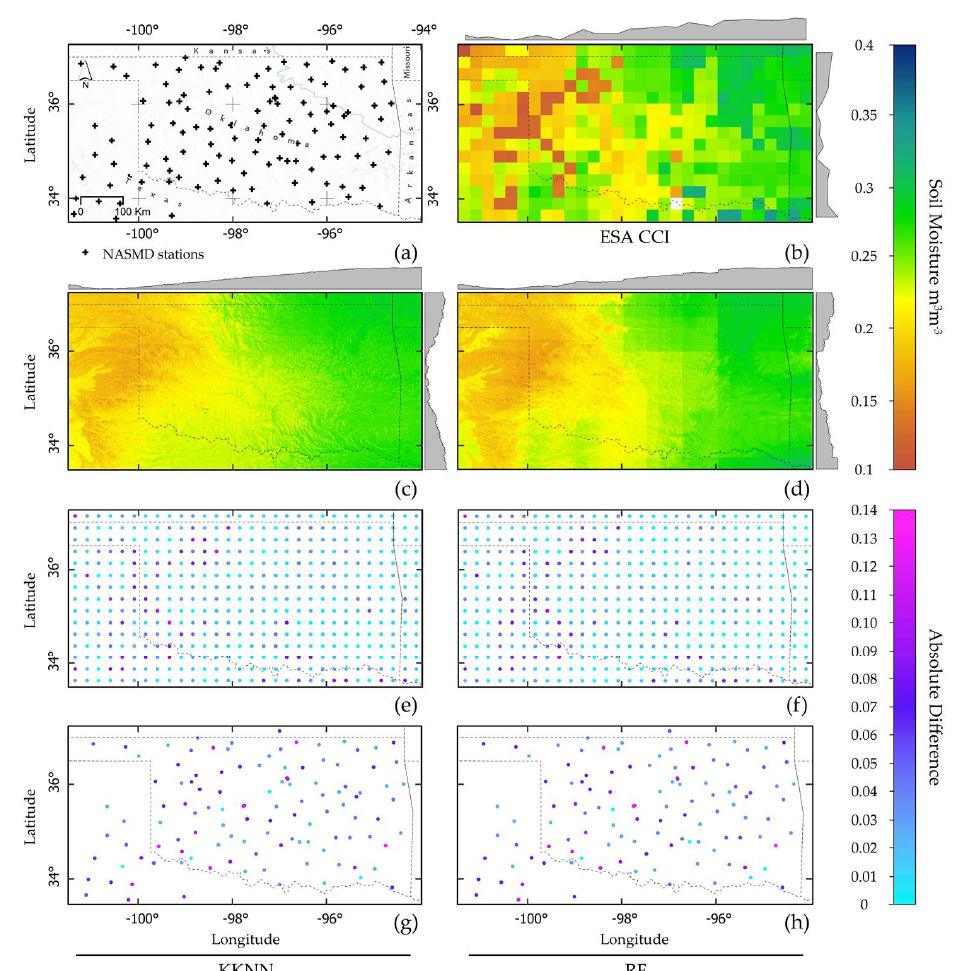
Figure 8. ( a ) Midwest ROI and distribution of NASMD stations throughout 2010; ( b ) mean soil moisture values of 12 monthly and 52 weekly layers based on the reference ESA-CCI values at 0.25 degrees of spatial resolution; ( c , d ) mean values of 1 km soil moisture predictions with KKNN and RF; ( e , f ) spatial distribution of mean absolute differences between ESA-CCI sampling points at 0.25 degrees and their spatially correspondent predicted soil moisture values in all layers at 1 km with KKNN and RF; ( g , h ) spatial distribution of mean absolute differences between all monthly and weekly soil moisture values from NASMD and predicted values at 1 km using the two methods tested.